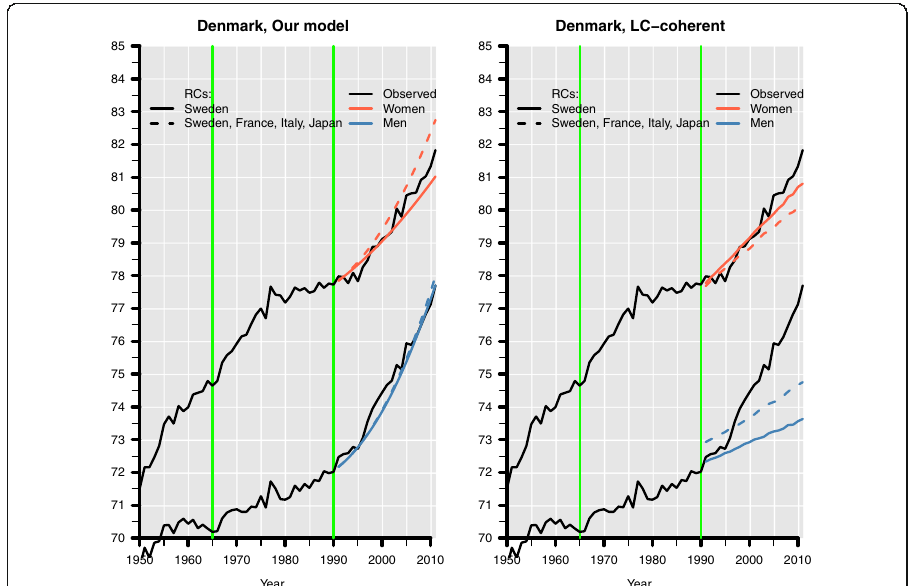
Fig. 10 Sensitivity of forecasted life expectancy at birth of the LC-coherent model ( right ) and the proposed model ( left ) for Danish women ( red ) and men ( blue ) using the RC Sweden ( solid lines ) and, in addition, France, Italy, and Japan ( dashed lines ). Observed data are depicted in black